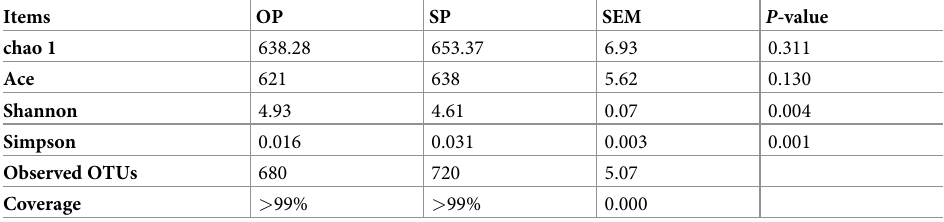
Table 6. OTU richness and alpha-diversity indices of rumen bacteria in calves fed SP and OP.